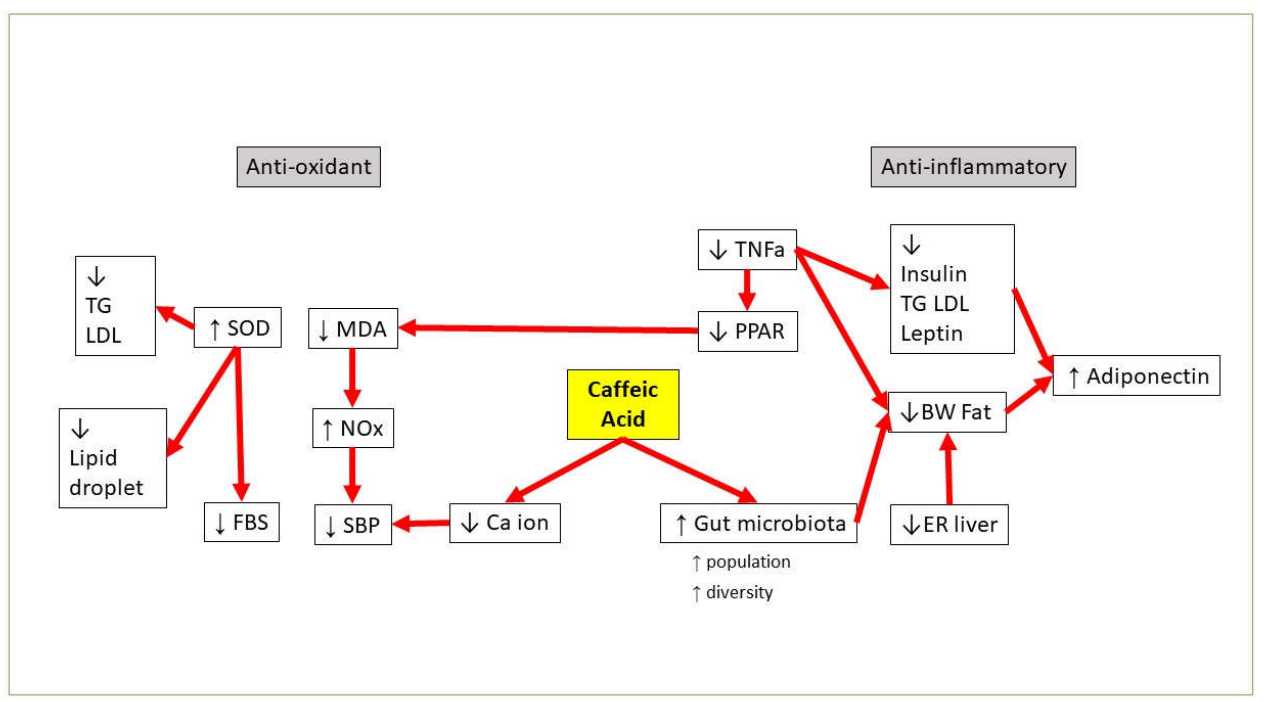
Figure 2. Proposed CA pathways against MetS.